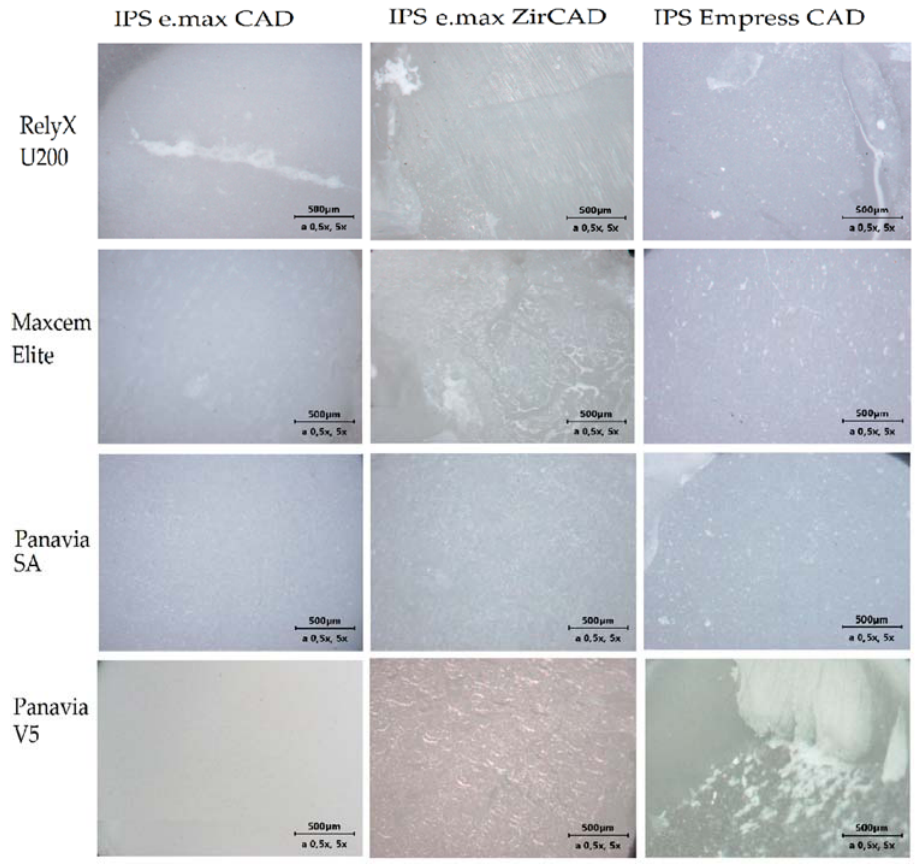
Figure 2. Light microscope photographs of different failure modes observed on ceramic surfaces.